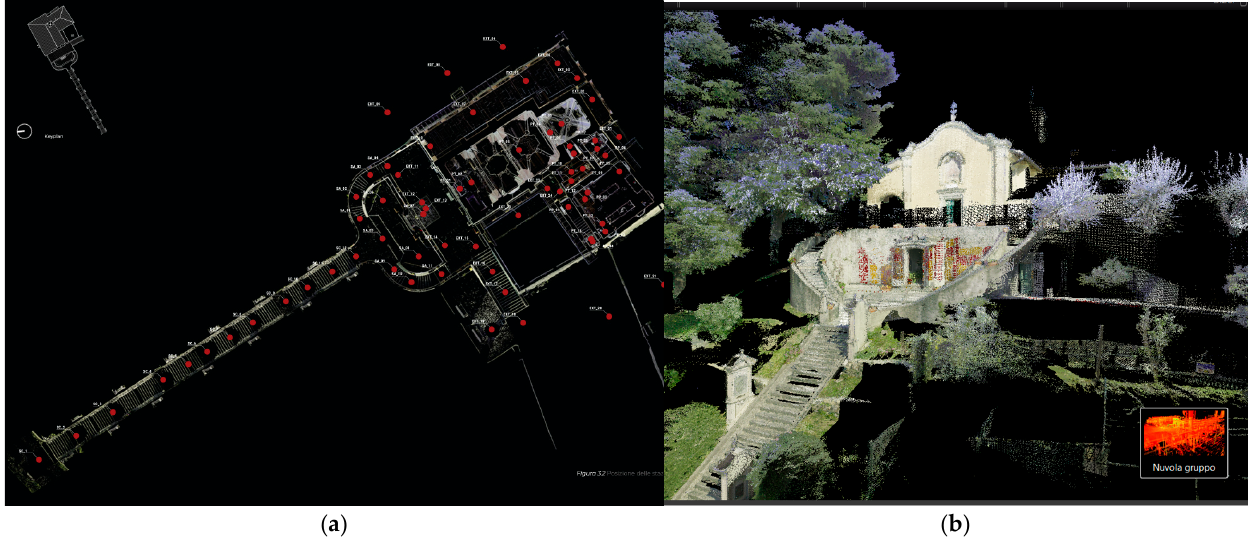
Figure 5. ( a ) Map of the single scan stations; ( b ) the final point cloud (screenshot from Leica Cyclone Register 360